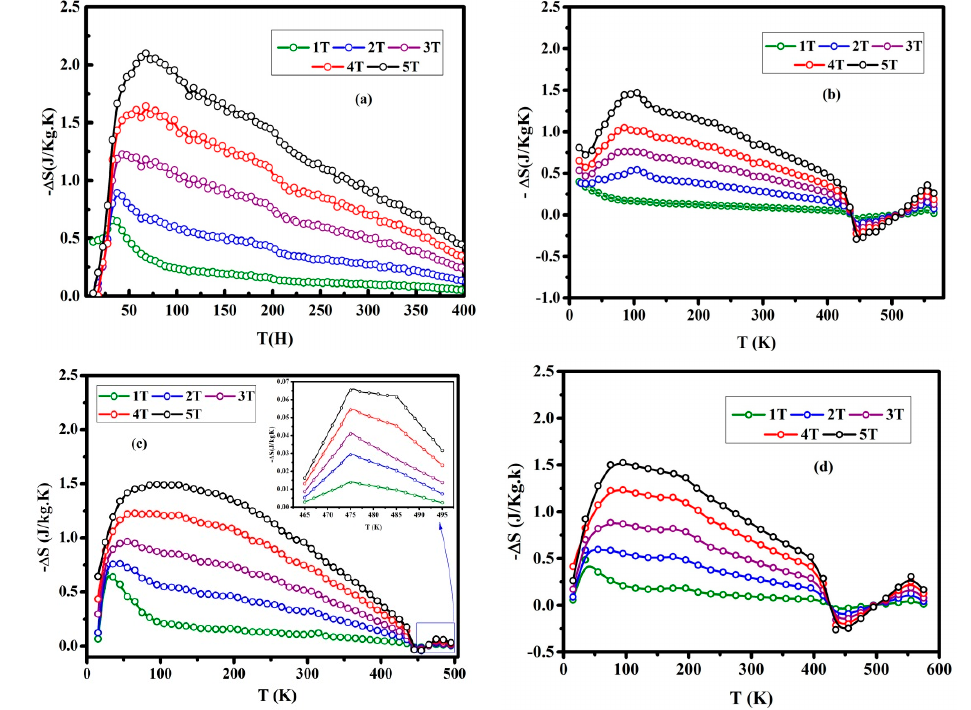
Figure 7. Magnetic entropy difference −Δ S M versus temperature for various magnetic field shifts for